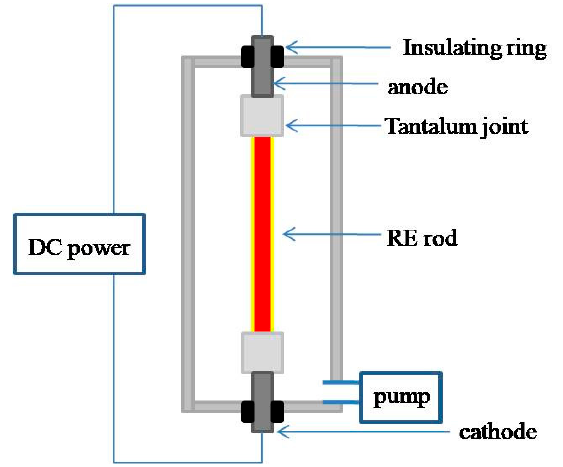
Figure 9. Schematic diagram of solid state electromigration.